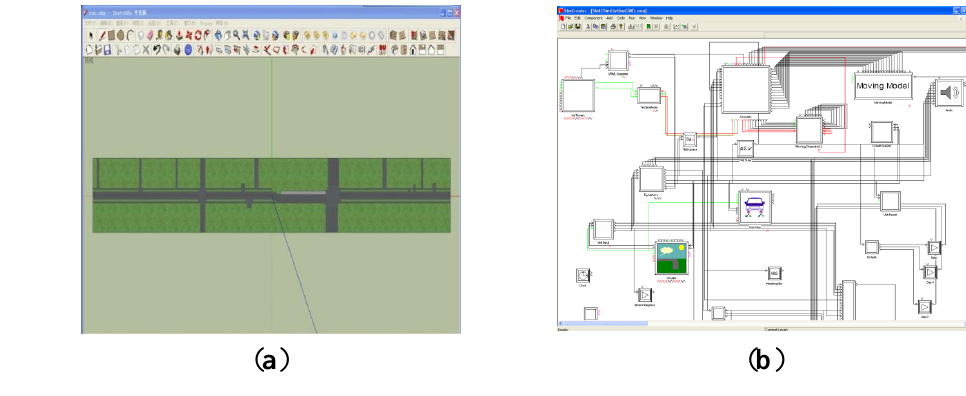
Figure 2. Interface of the simulator software; ( a ) SimVista. ( b )